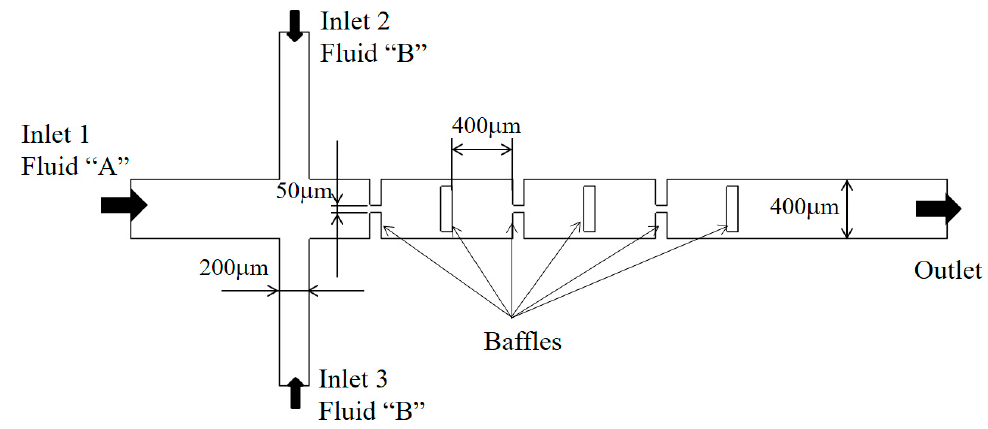
Figure 3. Diagram of the micromixer experimented by Chung et al. [24].